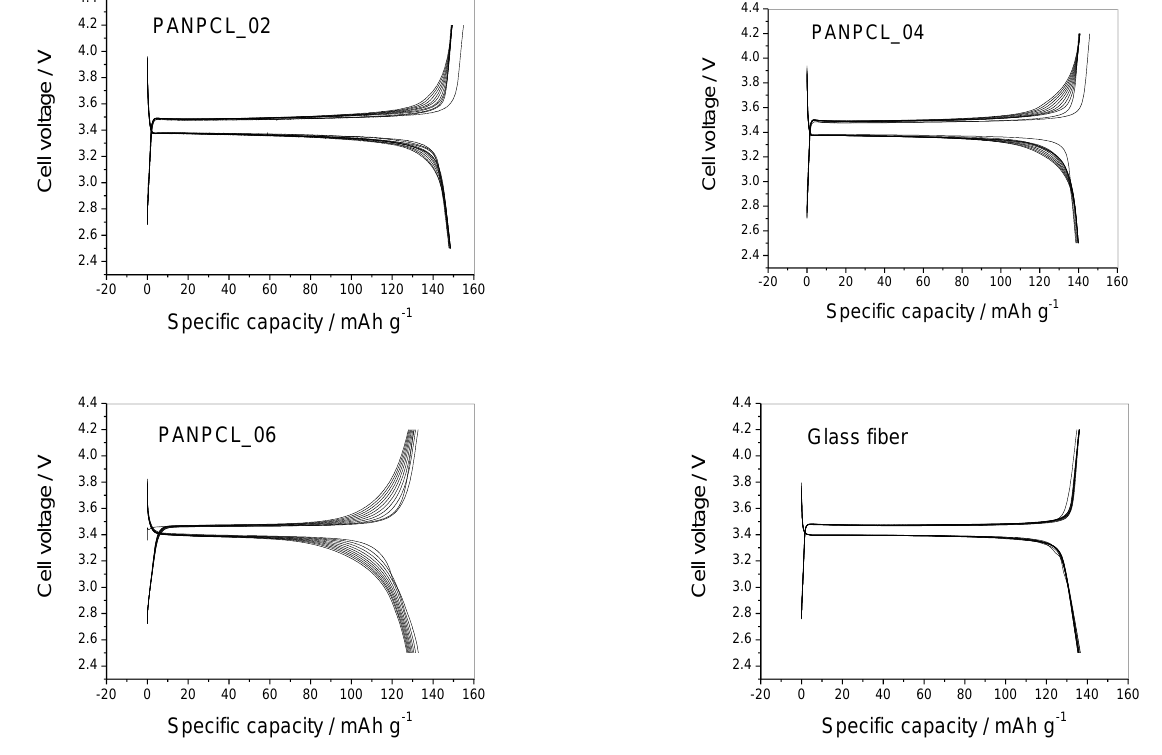
Figure 8. Voltage profiles as a function of the specific capacity for the first ten charge/discharge cycles of cells made with separators with different PAN/PCL ratios conducted at 0.1 C rate. For reference, the voltage profiles for a cell made with the glass fiber separator are also reported.